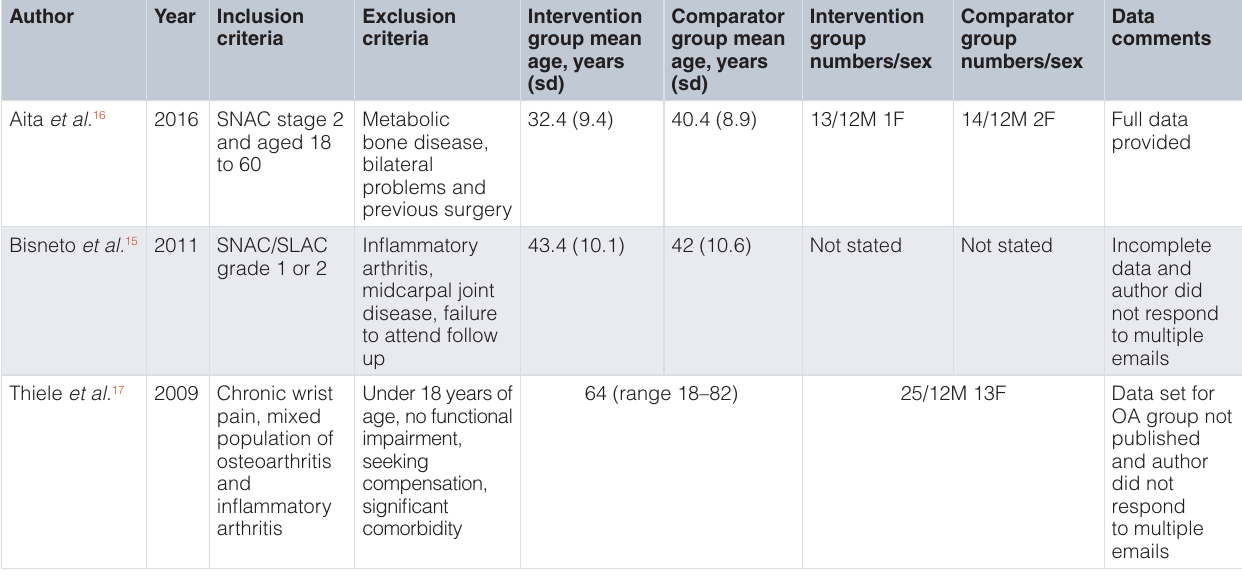
Table 2. Details of study participants demographics, inclusion/exclusion criteria and whether data was